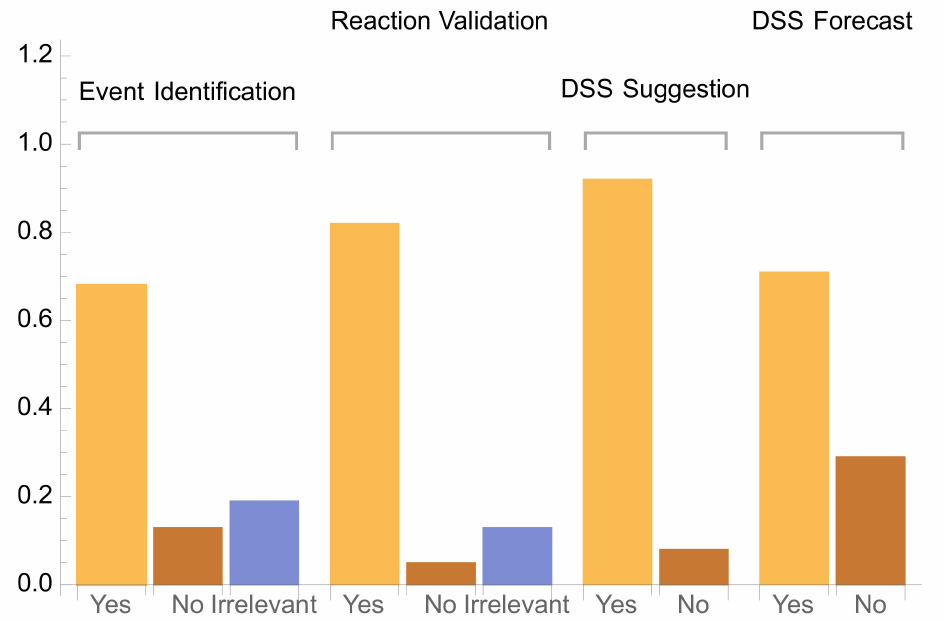
Figure 9. WTM and DSS preliminary evaluation results of early